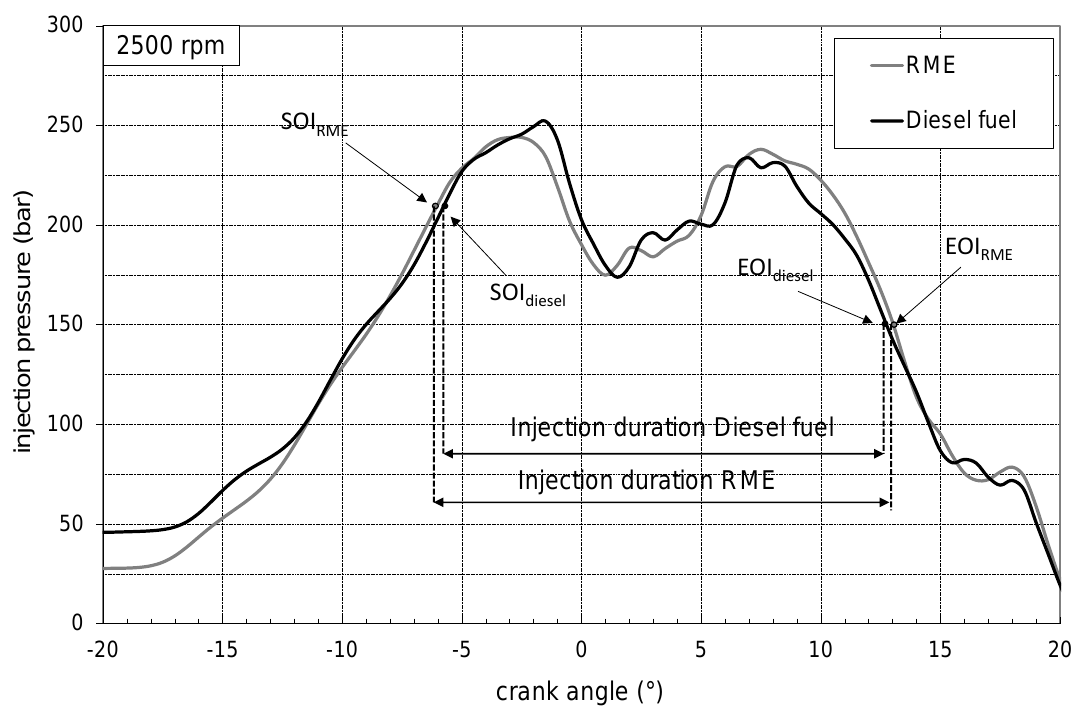
Figure 12. Injection durations with the RME and the diesel fuel at 2500 rpm and at full load. The effect of the rotational speed on the differences in the injection advance and in- jection duration will be commented on by analyzing Figures 13 and 14, respectively.